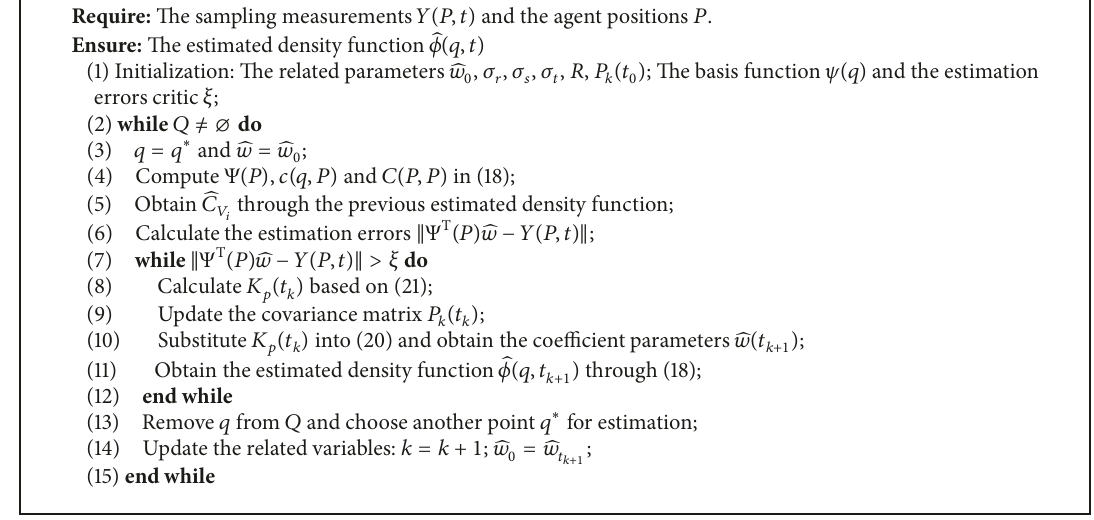
Algorithm 2: The improved KF-RBF based estimation